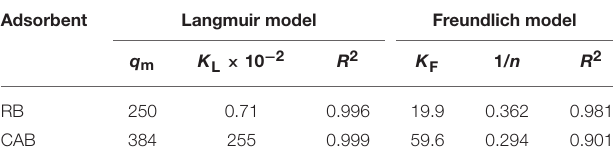
TABLE 1 | Parameters of isotherm models for CR adsorption on RB and CAB ( q max : mg · g − 1 , k L : L · mg − 1 , k f : mg · g − 1